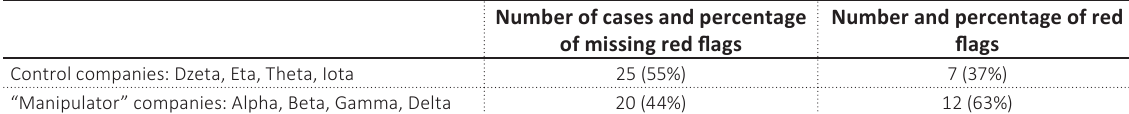
Number of cases and percentage Number and percentage of red of missing red flags